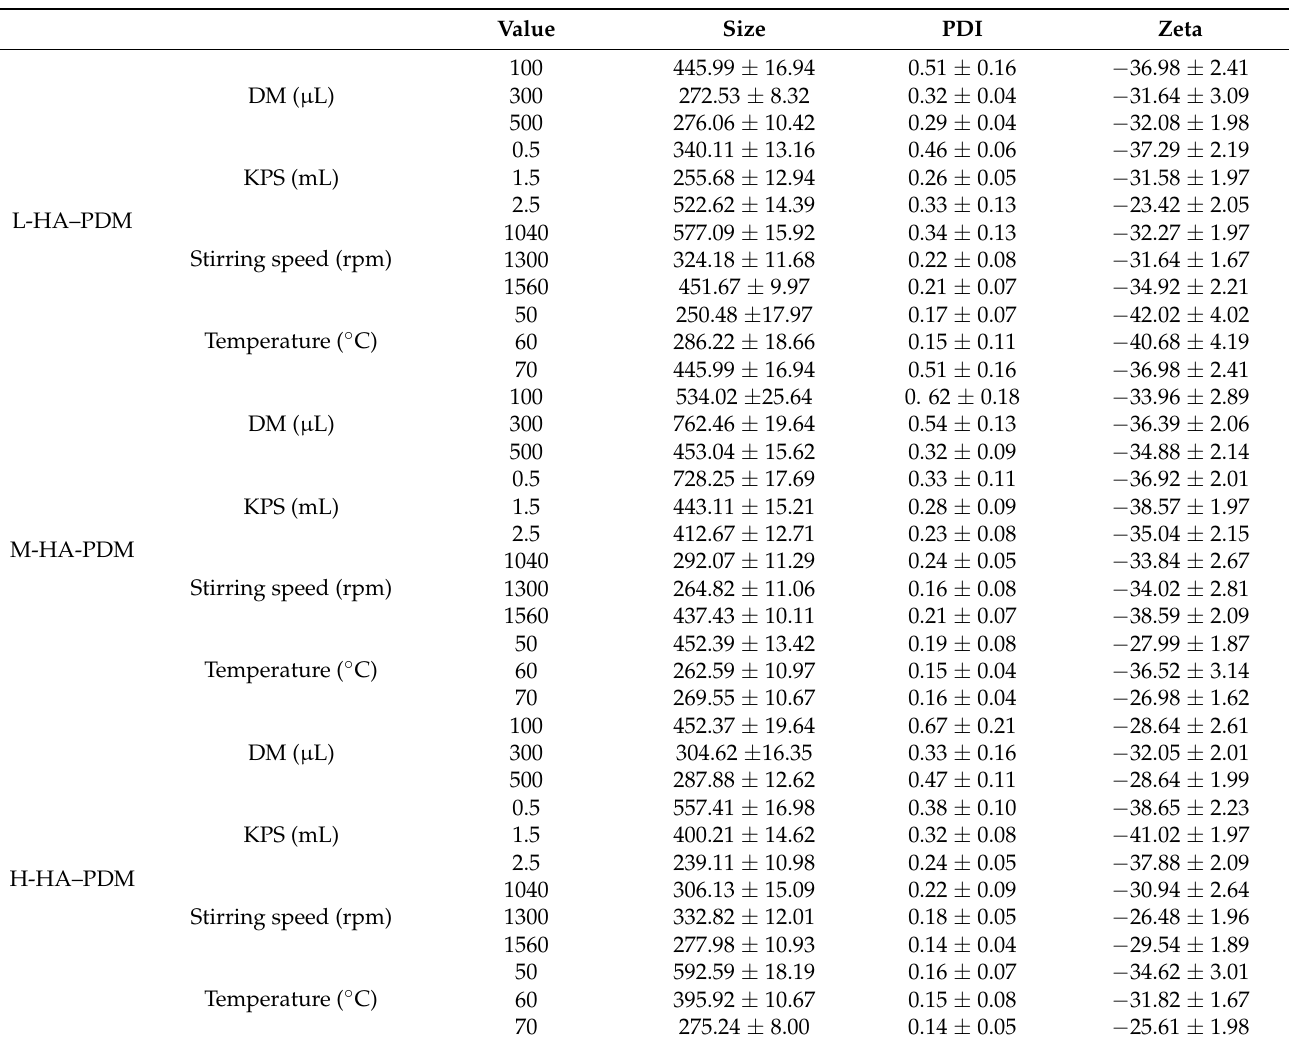
Table 2. Single-factor optimization: process and formulation.